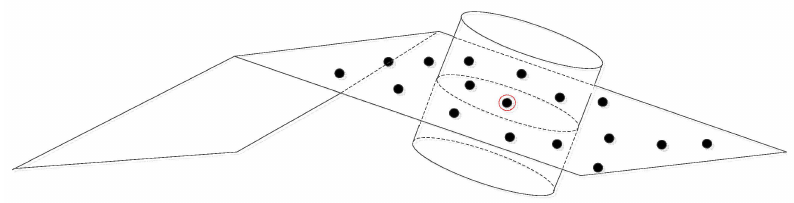
Figure 1. Schematic concept of the adaptive cylinder neighborhood